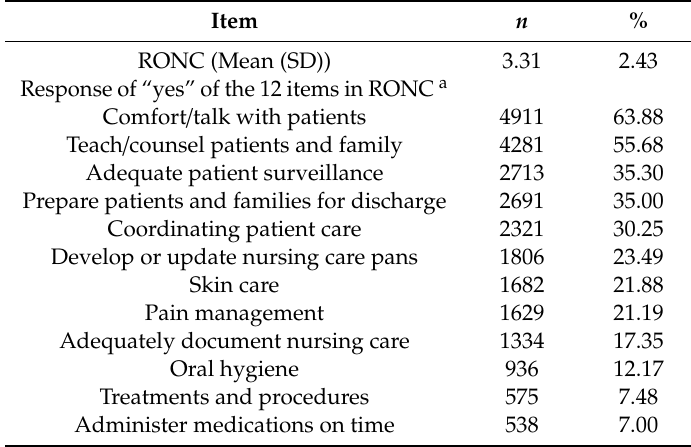
Table 2. Description of RONC ( n = 7688).